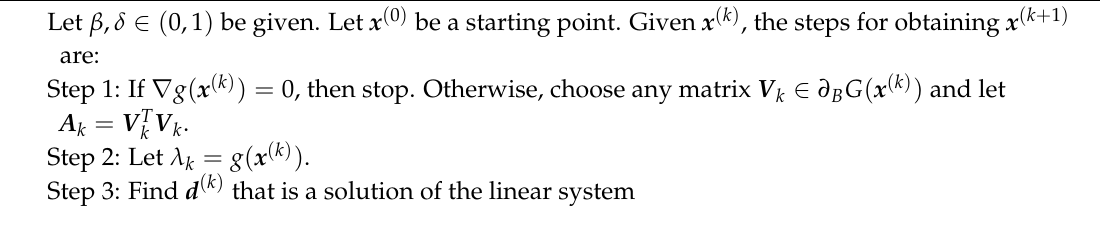
Algorithm 1: The damped Gauss-Newton method for solving